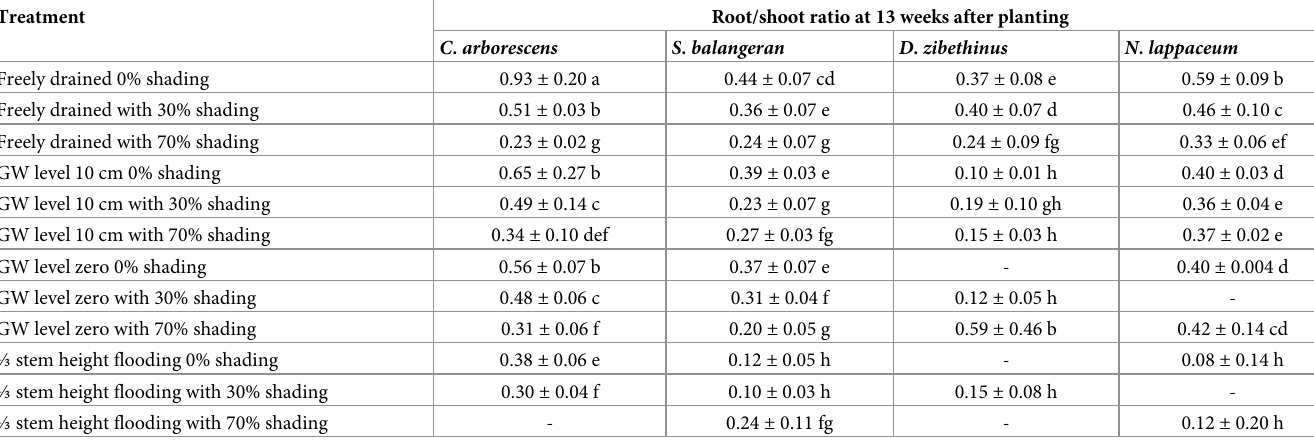
Table 7. Root:Shoot Ratio (RSR) of four plant species under treatment combination of inundation and shading.